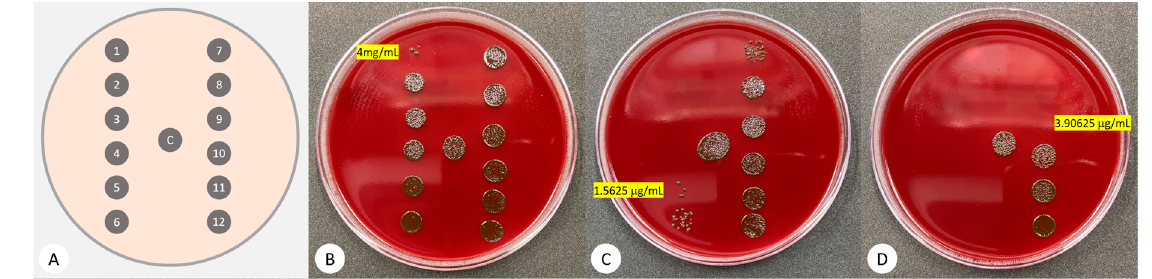
Figure 1. (A) A diagram depicting the distribution of 5 µL drops from 12 wells that were diluted by a two-fold factor. ‘C’ refers to untreated control; ( B ) Hyaluronic acid from 4 mg/mL to 2 µg/mL; ( C ) Azithromycin from 25 µg/mL to 0.012 µg/mL; ( D ) Chlorhexidine from 1 mg/mL to 0.49 µg/mL.